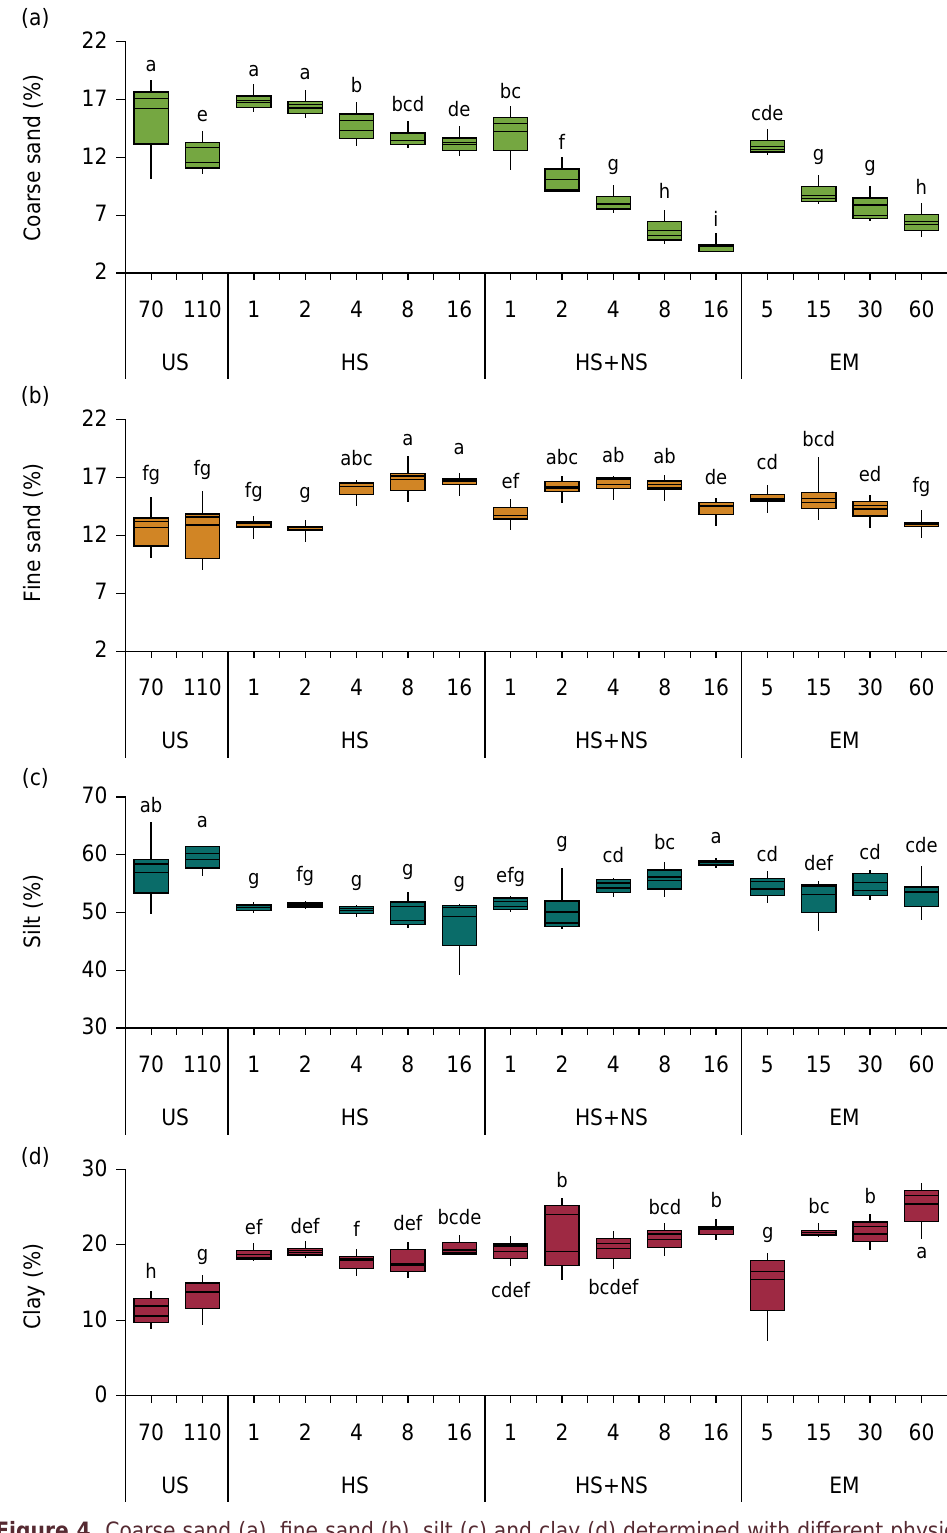
Figure 4. Coarse sand (a), fine sand (b), silt (c) and clay (d) determined with different physical dispersion methods. US: ultrasonication at 70 and 110 J mL -1 ; HS: horizontal shaking at 150 cycles per min without nylon spheres for 1, 2, 4, 8 and 16 h; HS+NS: horizontal shaking at 150 cycles per min with nylon spheres for 1, 2, 4, 8 and 16 h; EM: shaking with an electric mixer at 12,000 rpm for 5, 15, 30 and 60